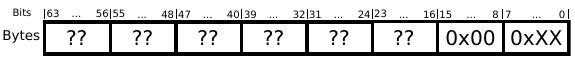
Figure 10. Illustration which bytes, and in which way these bytes of a vulnerable pointer must be modified, for the exploit to succeed with